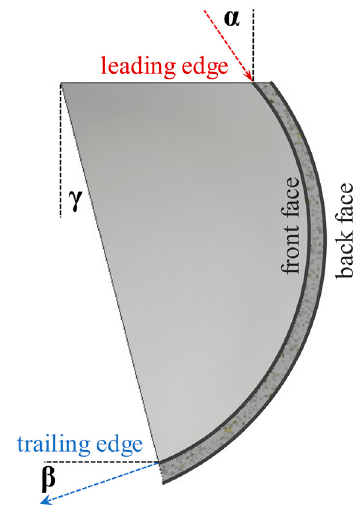
Figure 10. Comparison of fluid velocity for the blade in its ( a ) original and ( b ) optimum position. In the figure, the legend values range from 0 (shown in blue) to 1.8 × 10 1 (red) with units of m/s. In the figure, the scientific notation of e as “multiped by 10 to the power of” is used, e.g., 1.8e+1 is equal to 1.8 × 10 1 .